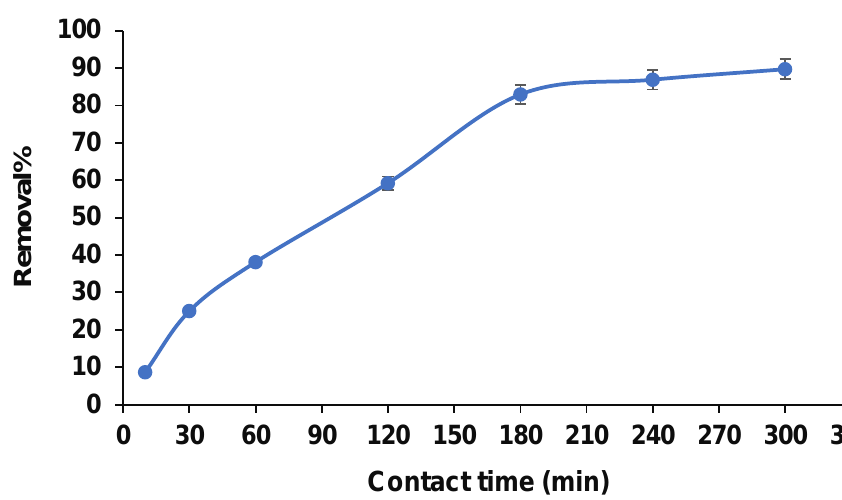
Figure 8. Effect of contact time on the removal efficiency (pH 5, 80 mg adsorbent dosage, and 20 mg.L -1 arsenic).